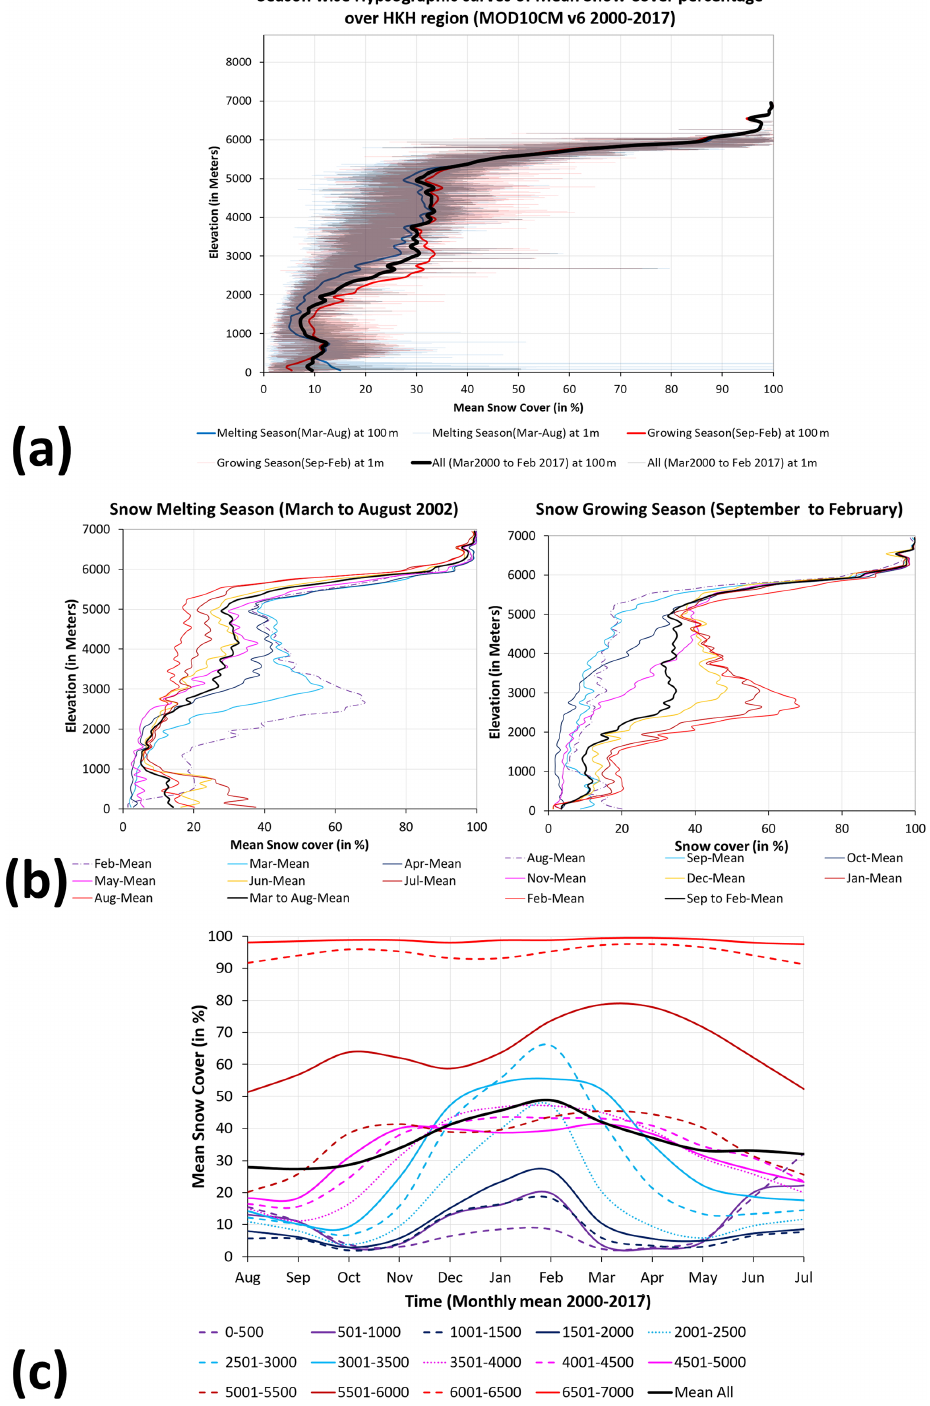
Figure 4. (a) The mean snow cover hypsographic curves during 2000–2017 over the HKH region. (a) Seasonal curves for the accumulating season (red line), melting season (blue line), and all seasons (black line). (b) Monthly composites (in percent) during the snow melting and accumulating seasons. (c) The variability in mean snow cover over the months (at different altitudes; < 5500m) shows the start of the decline in snow cover from the month of March onwards (black line is the